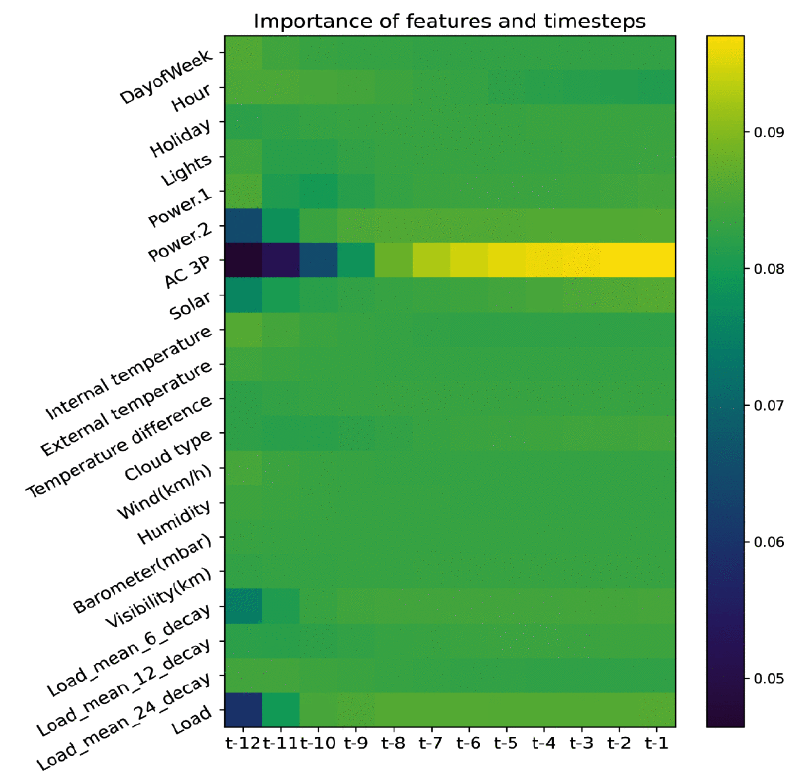
Figure 11. The feature-wise temporal importance in IM-LSTM